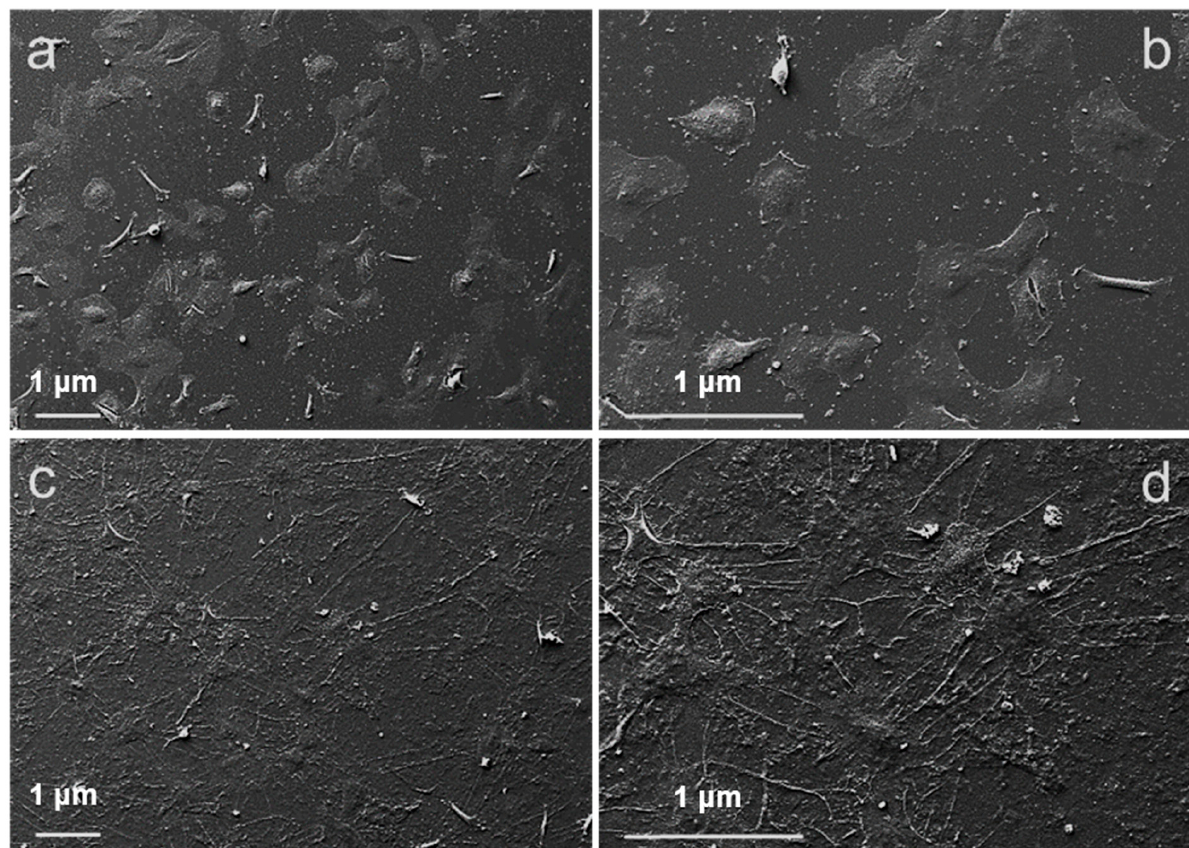
Figure 2. SEM investigation of primary fibroblasts adhesion on glass control and on PEDOT:Nafion. Morphology of cells seeded on control glass ( a , b ) and PEDOT:Nafion coatings ( c , d ) at 12 h after seeding at a density of 1 × 10 4 cells/cm 2 . Panels ( b , d ) magnified images from ( a , c ), respectively.